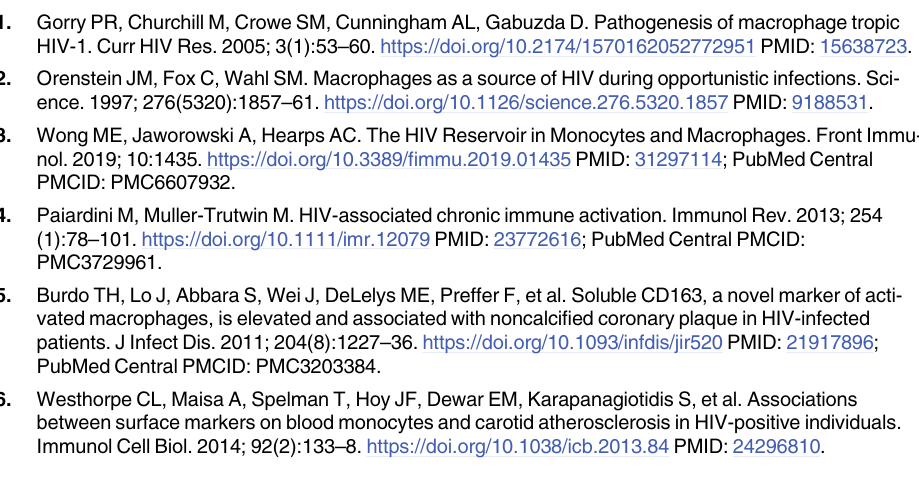
S4 Fig. Effect of traditional inflammasome “Signal 2” inhibitors on HIV-induced IL-1 β & IL-18 processing. Monocyte-derived macrophages (MDMs) (1 x 10 6 ) were infected with HIV- 1 for 12 h in the presence or absence of Cathepsin B inhibitor (CA-074) (100 μ M), DPI (20 μ M), NAC (20mM) chloropromazine (50 μ g/ml) and the presence of pro-IL-1 β , pro-IL-18, cleaved IL-1 β and cleaved IL-18 was investigated via western blotting.